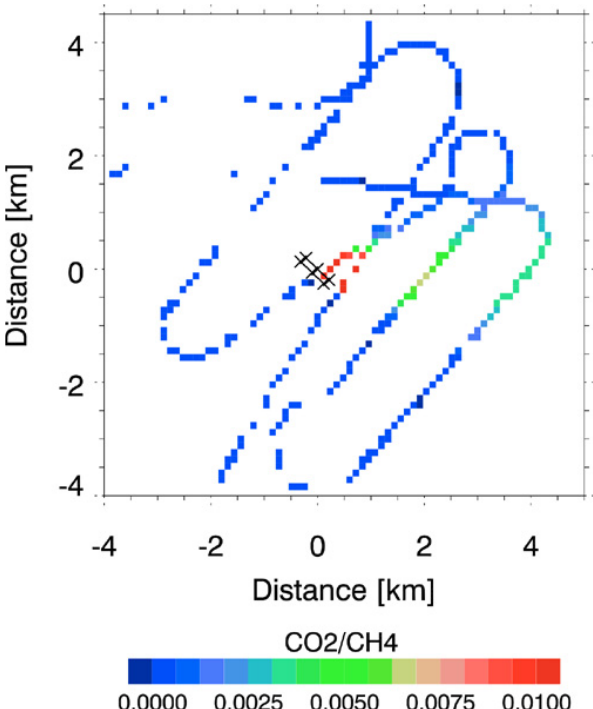
Fig. 10. Systematic biases due to aerosol alone at the example of J¨anschwalde power plant. Maximum error in close vicinity to the power plant is about 0.03% relative to the background column. The overall plume model inversion is only biased by about + 0.4% of the true emission